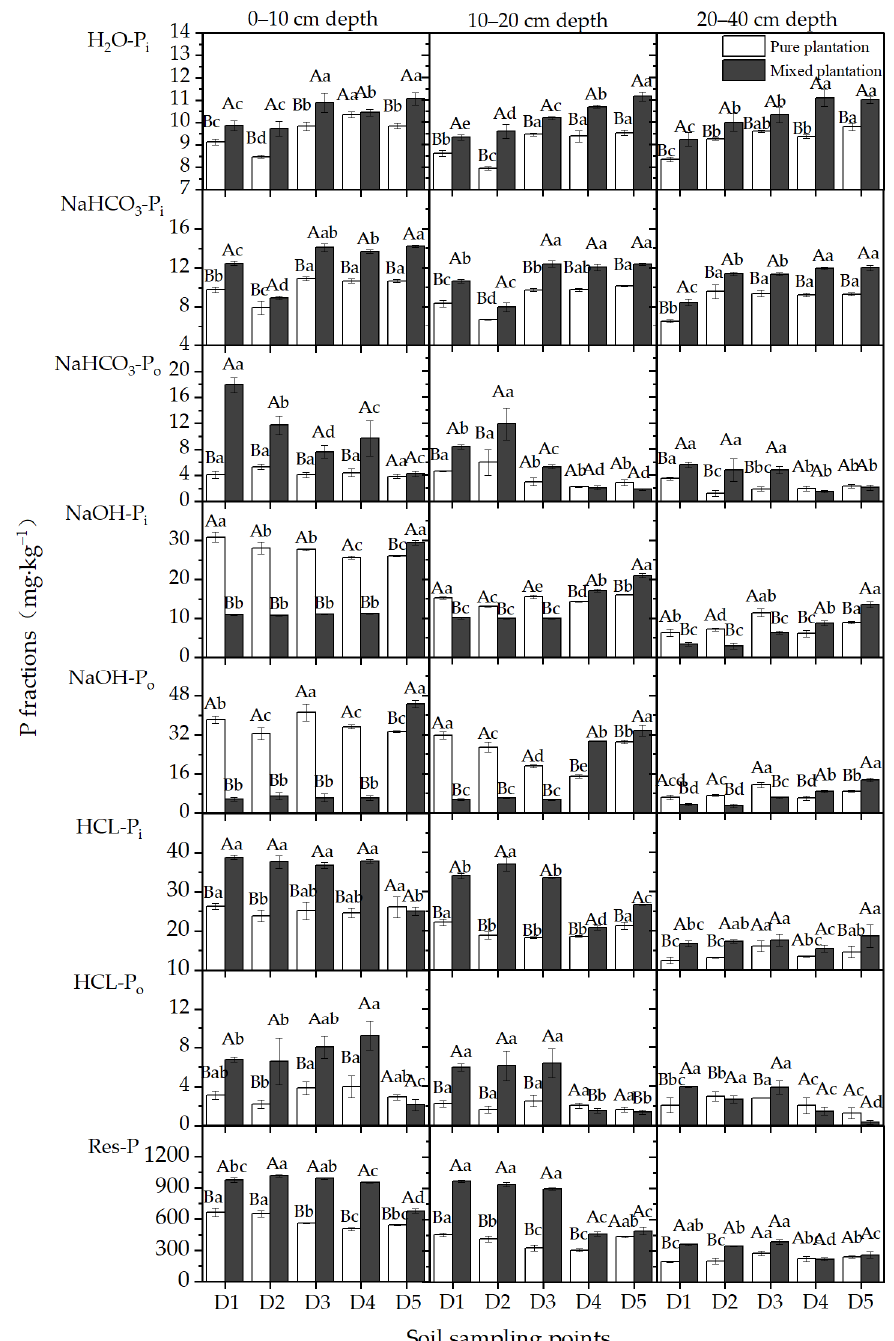
Figure 6. Concentrations of P fractions at different soil sampling points of the pure larch plantation and mixed larch ‐ ash plantation. Lowercase letters indicate significant differences among different soil sampling points in the same plantation, p < 0.05; capital letters indicate significant differences among different plantations at the same sampling point, p < 0.05. n = 3, standard deviation bars are shown.